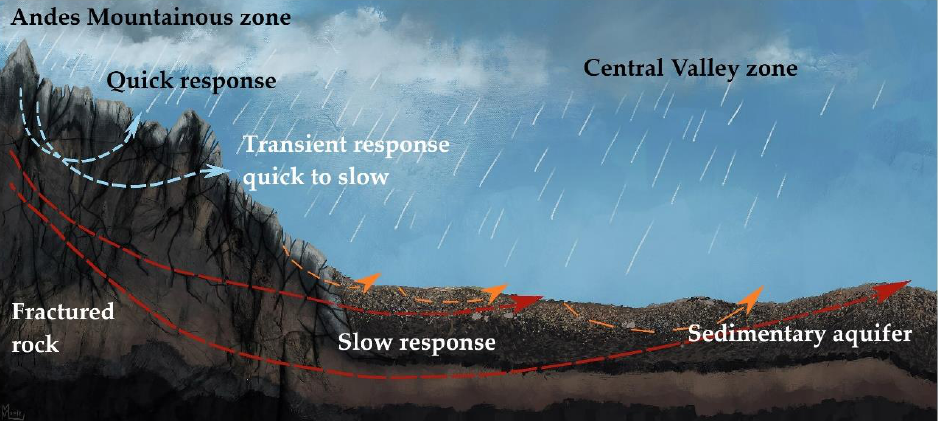
Figure 6. Conceptual representation of the groundwater storage response in watersheds with fractured and sedimentary influence. The dashed lines represent groundwater recharge in the Andes Mountains and the Central Valley.